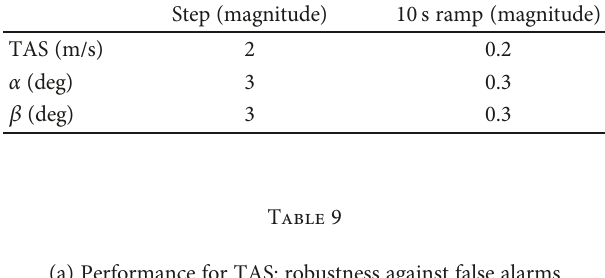
Table 8: Step magnitude and ramp slope for fault modeling. Step